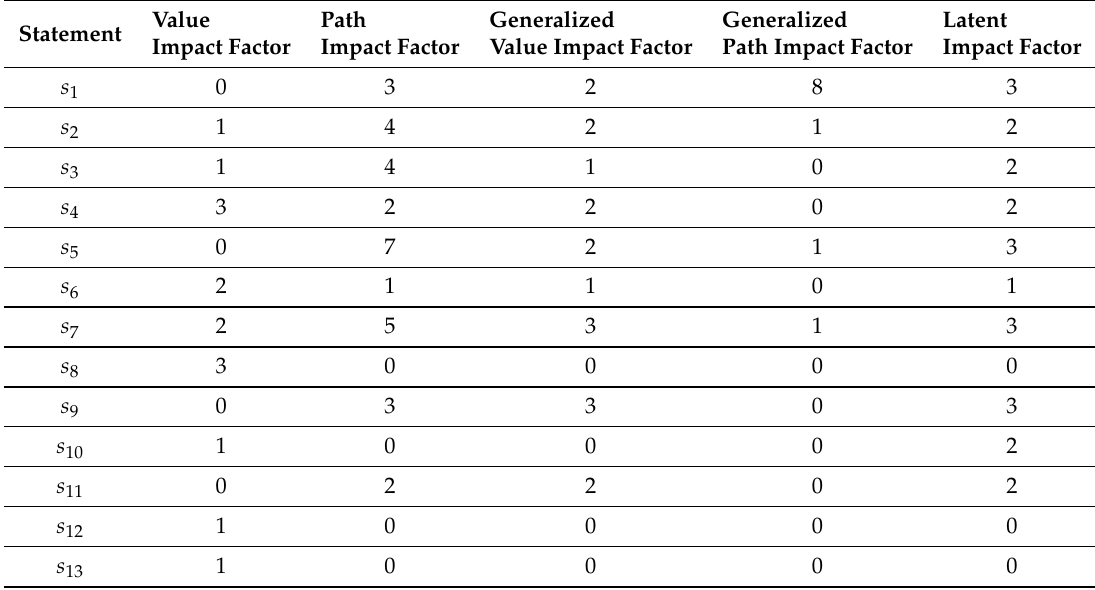
Table 5. The first five impact factors of all statements in Program 1.